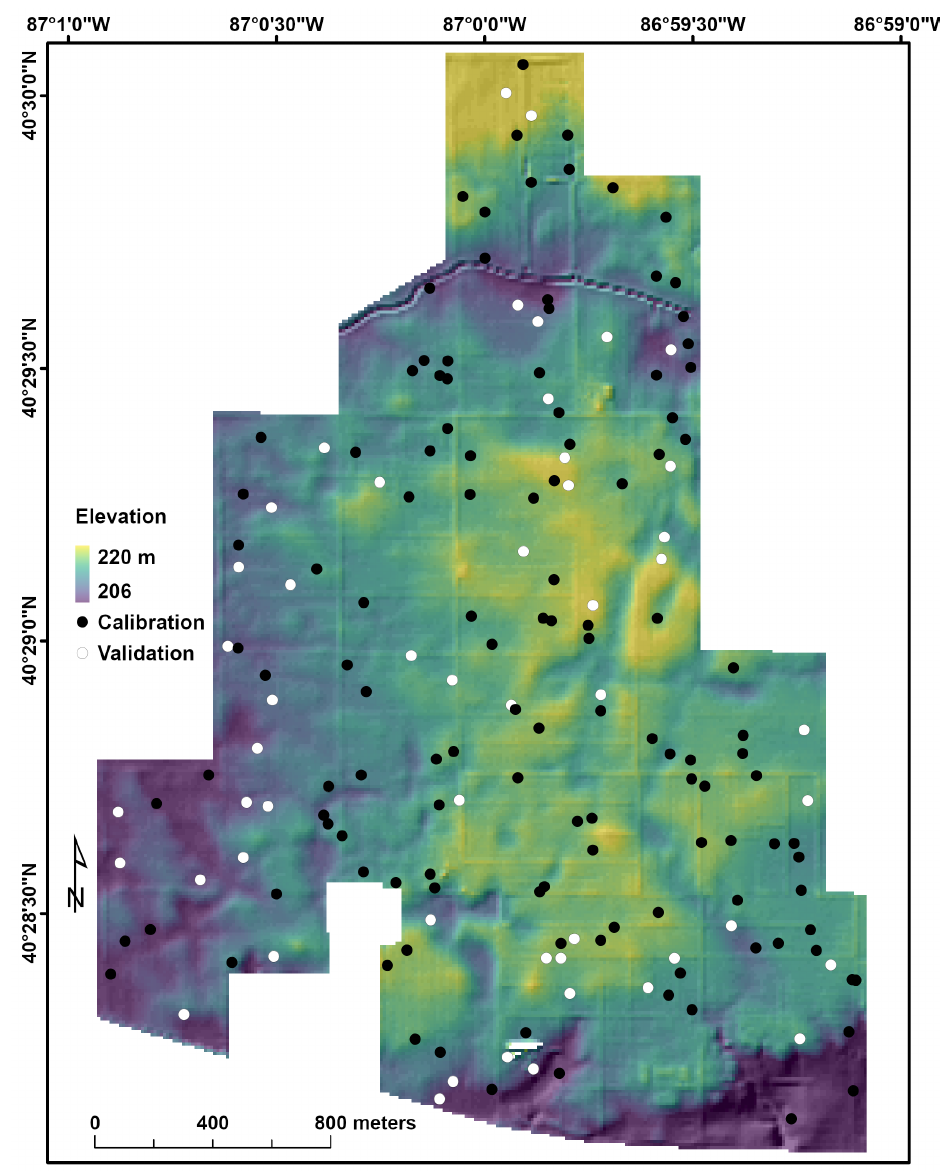
Figure 1. Study area and sampling locations over a lidar-derived elevation map over hillshade base map. Seventy percent of the samples were used for model calibration and 30 percent for validation.